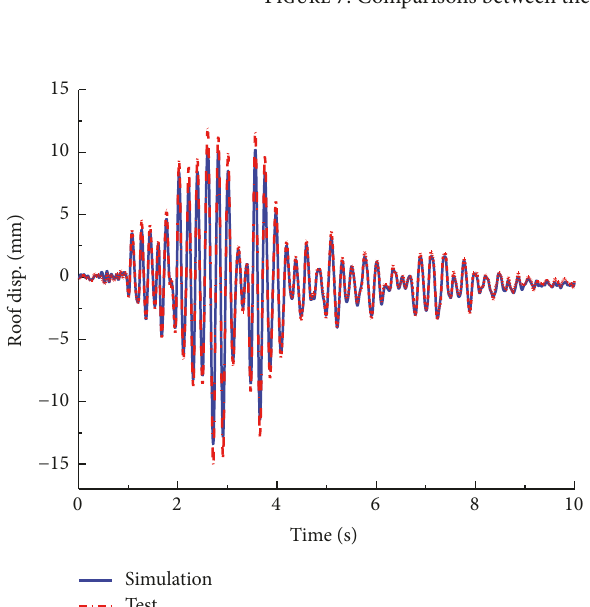
Figure 7: Comparisons between the numerical simulations and the test results.